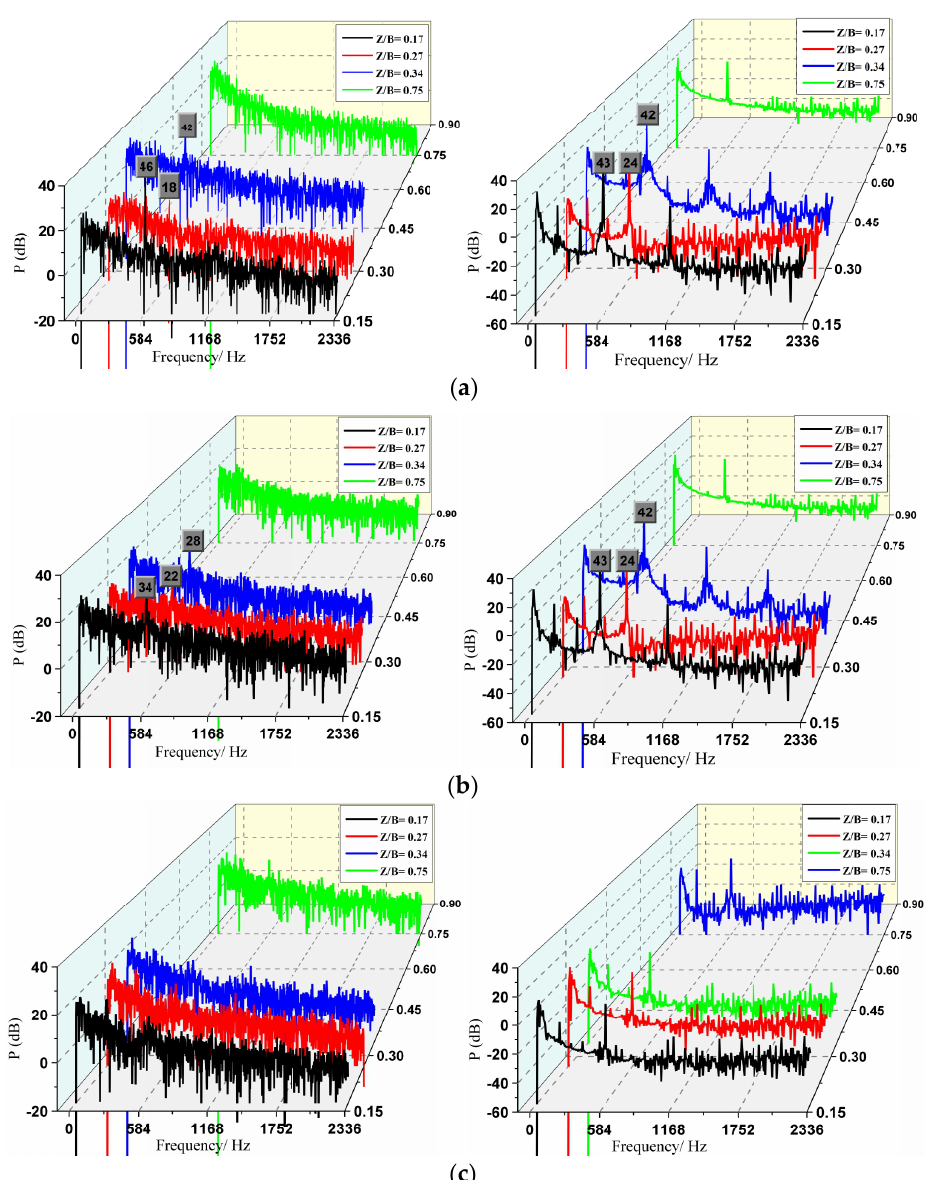
Figure 8. Power spectrum of volute pressure fluctuation at three measurement points with the flow rate best efficiency point (BEP); ( a ) Point 01 (exactly at the tongue); ( b ) Point 06 (52˚ from the tongue); ( c ) Point 09 (187˚ degree from the tongue).